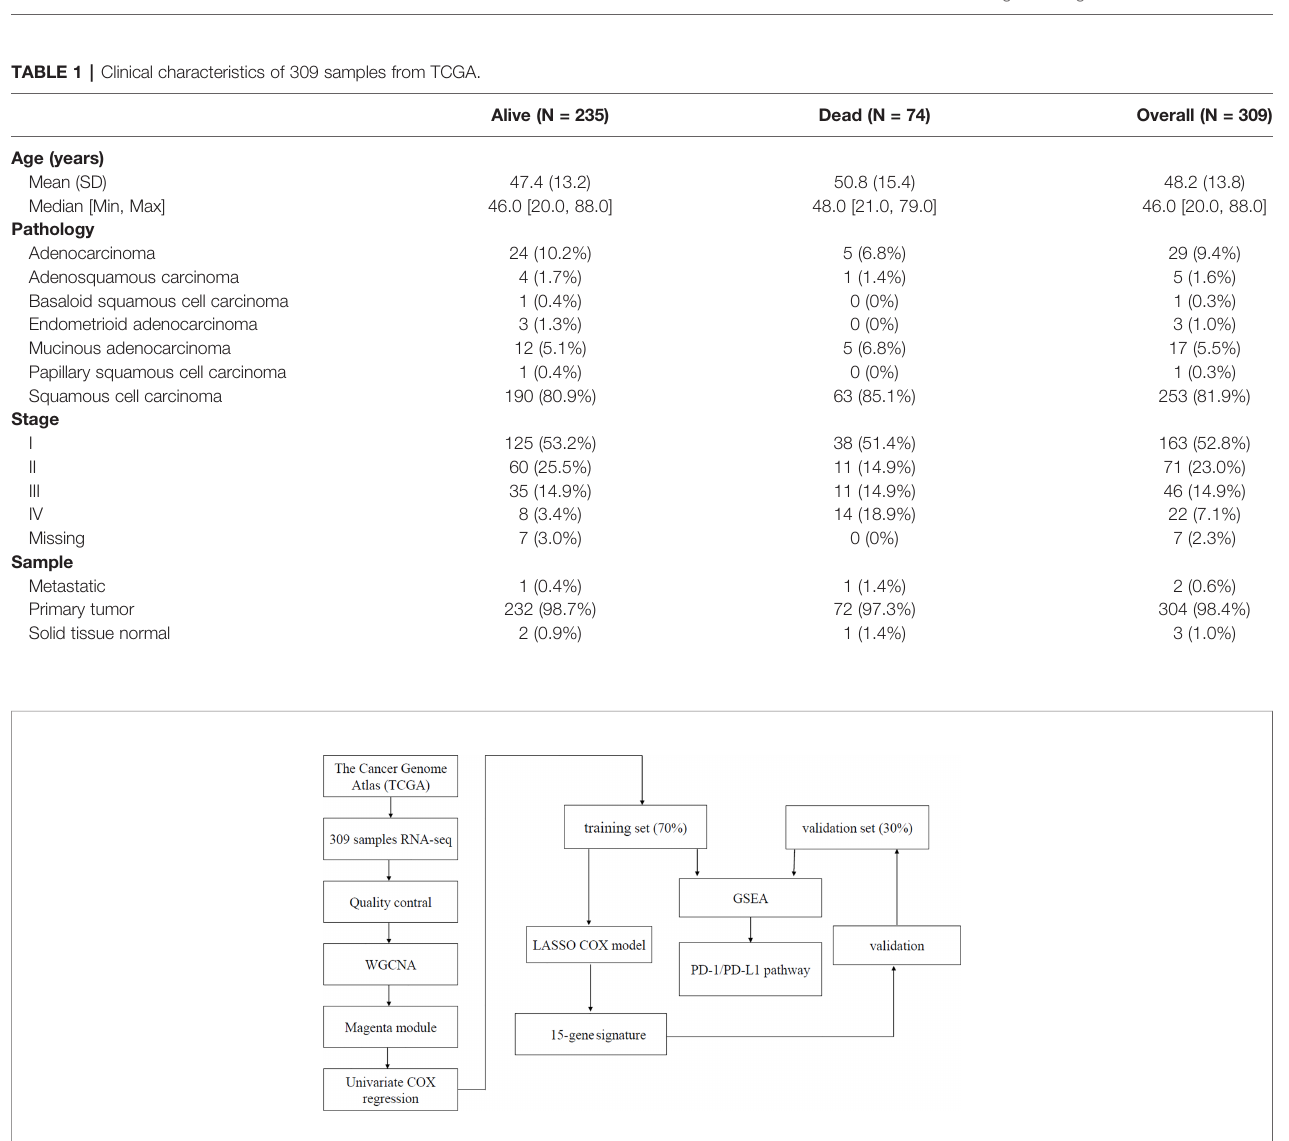
FIGURE 1 | Flowchart of the 15-gene signature prognostic model construction process.